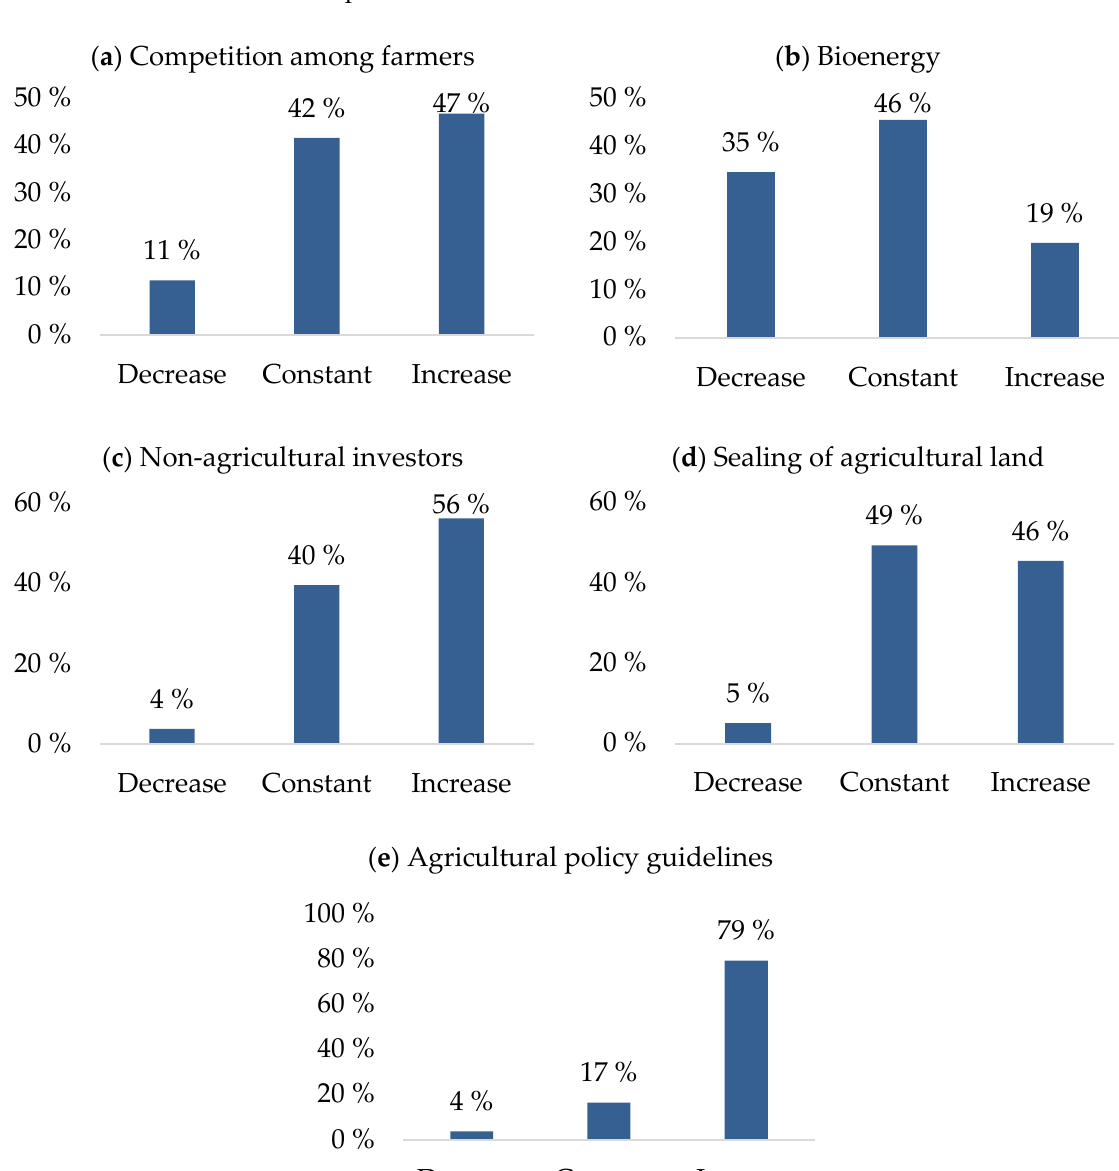
Figure 5. Farmers’ perceptions of the future development of the magnitude of the factors influencing the agricultural land rental market (N = 156): ( a ) Competition among farmers, ( b ) Bioenergy; ( c ) Non-agricultural investors; ( d ) Sealing of agricultural land; ( e ) Agricultural policy guidelines.